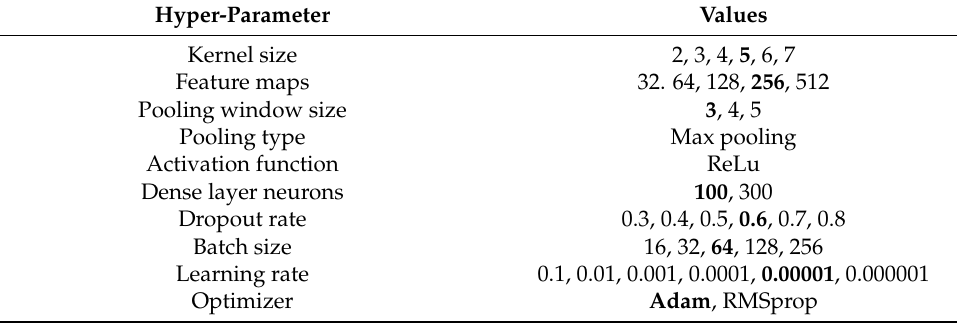
Table 3. Hyper-parameters for the